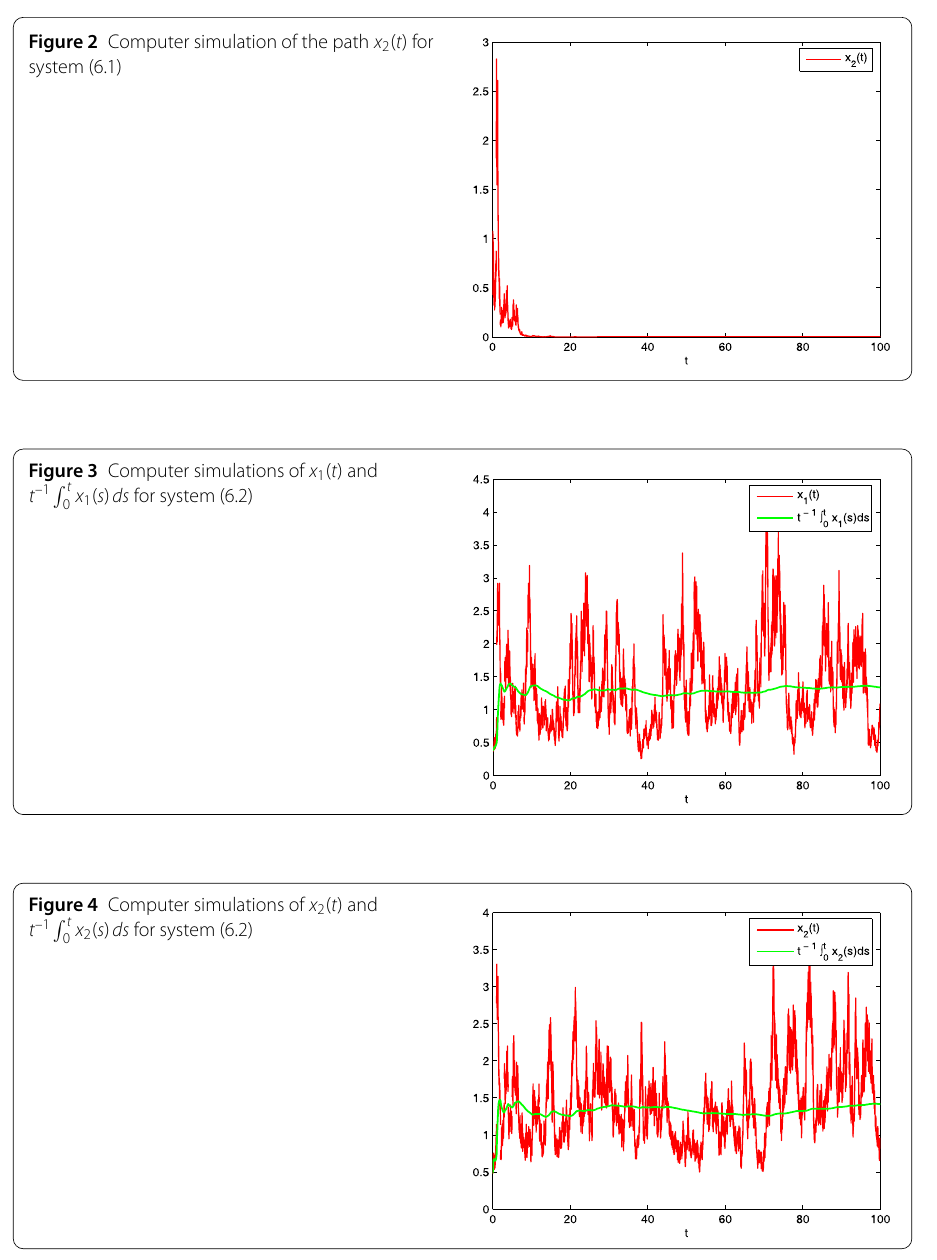
Figure 2 Computer simulation of the path x 2 ( t ) for system (6.1)